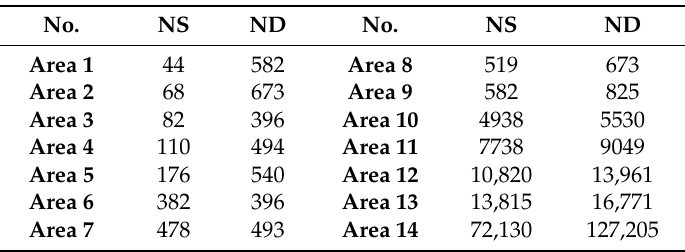
Table 2. Fourteen pairs of road networks used for experiments. NS represents the node number of the source map, and ND represents the node number of the destination map. No. NS ND No. NS